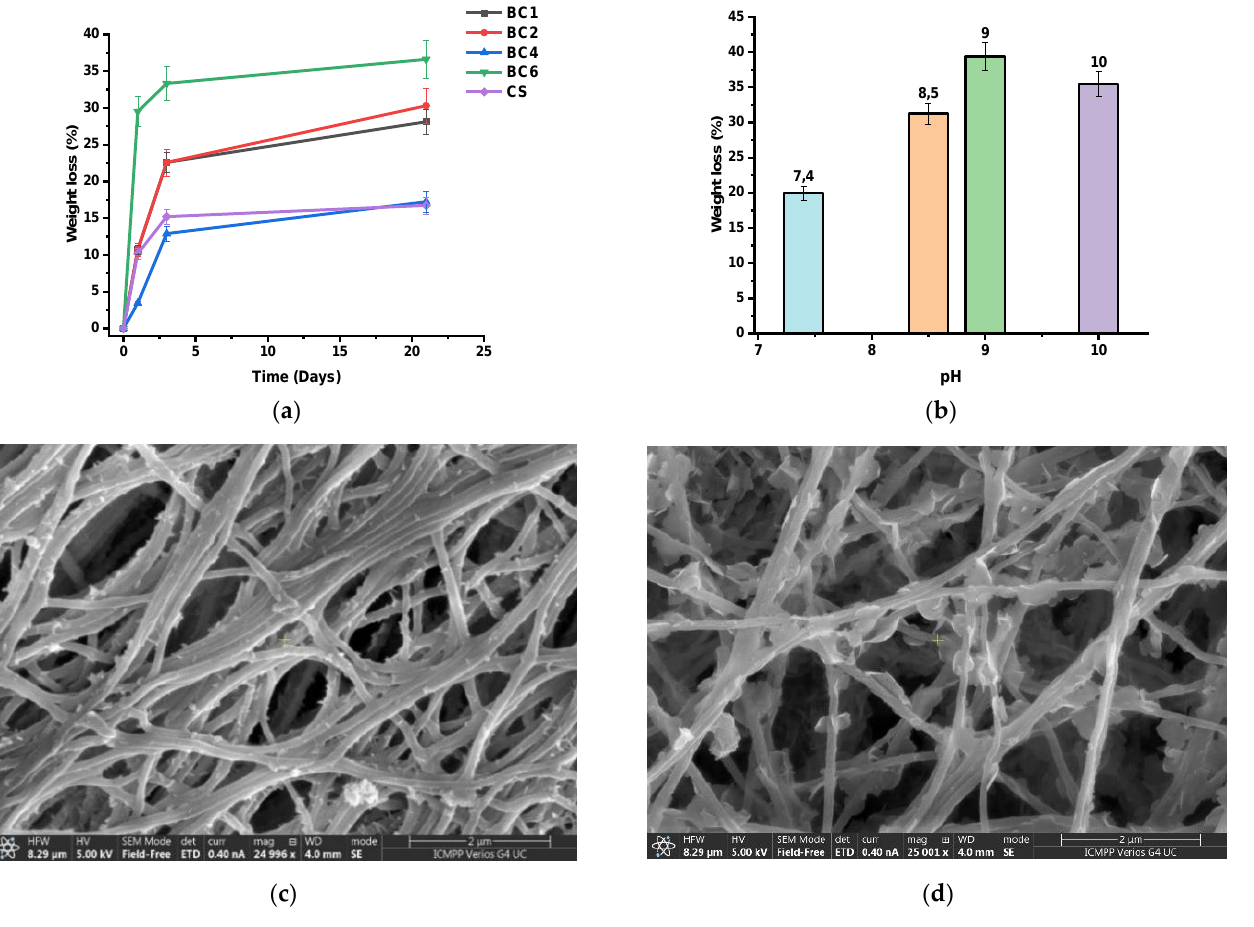
Figure 8. ( a ) Representative curves for kinetics of enzymatic biodegradation in lysozyme medium (376 U/mL) at physiological pH during 21 days; ( b ) maximum mass loss of the BC1R sample after 21 days of incubation in media of different pHs; ( c , d ) SEM images of BC1R fibers subjected to biodegradation, at pH 7.4 and 10, respectively.